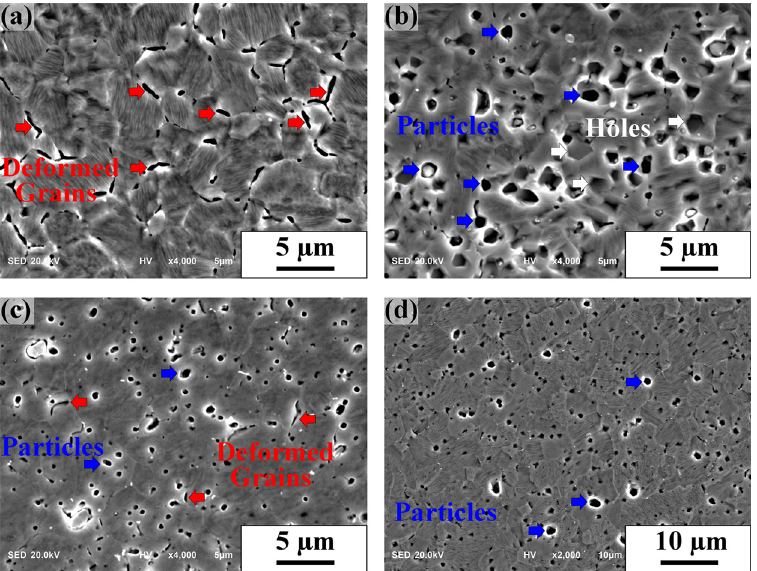
Figure 7: Secondary electron images of the microstructure in the ( a ) normal SZ, ( b ) BB, ( c ) DB, and ( d ) WB. ( a ) , ( b ) , and ( c ) are the results at rotational speed of 300 rpm, and ( d ) is the result at 400 pm.